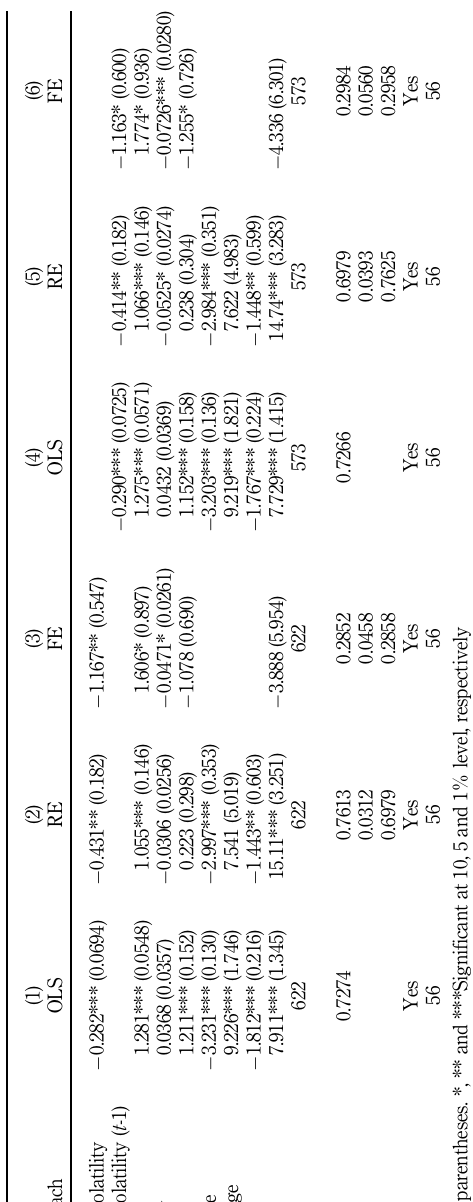
Table 4. OLS, RE and FE estimations using standardized value (standard deviation) of exchange